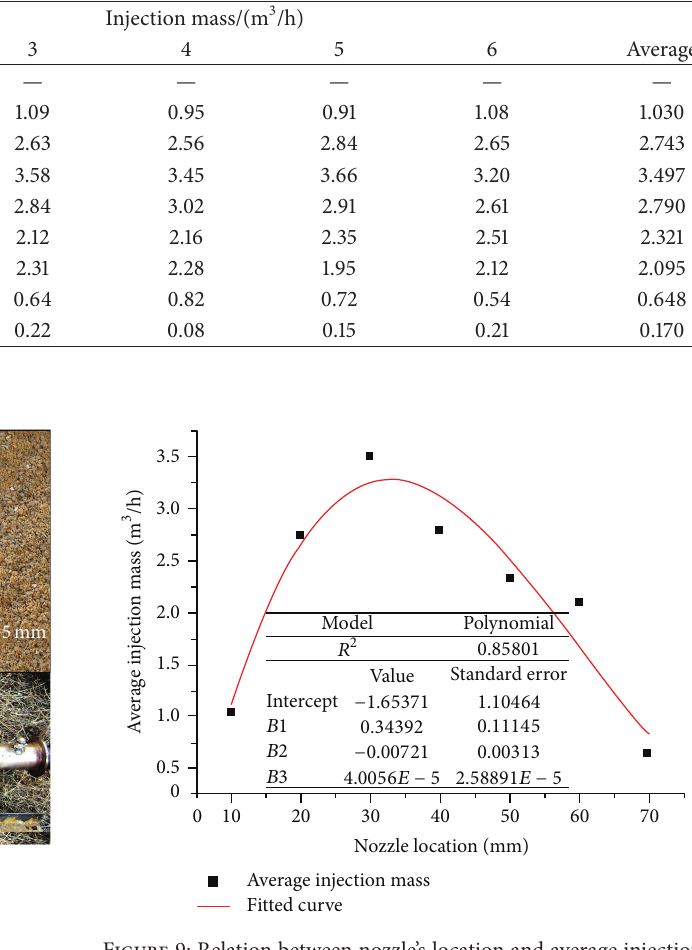
Figure 9: Relation between nozzle’s location and average injection